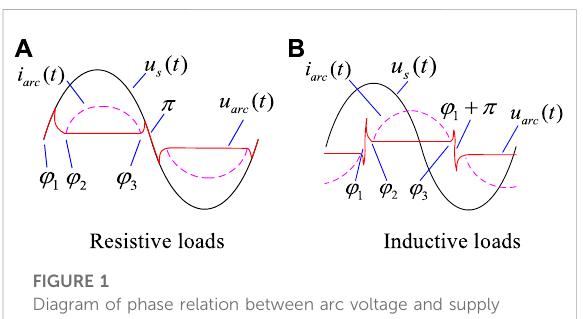
FIGURE 1 Diagram of phase relation between arc voltage and